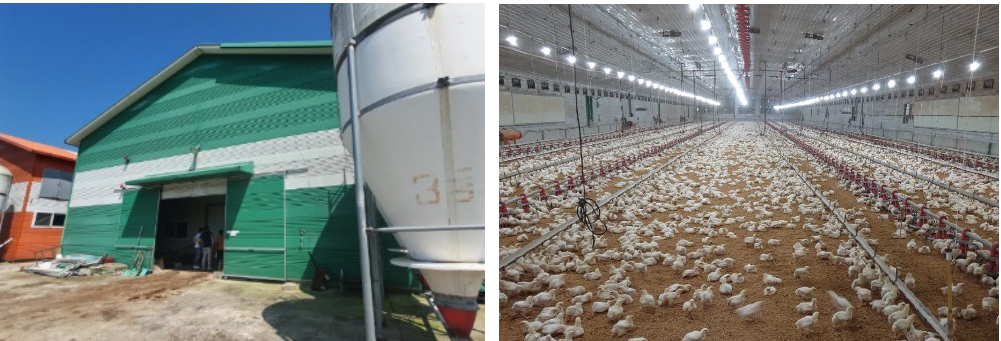
Figure 2. Outside and inside the field test facility for experiment (Latitude: 35.277, Longitude: 126.511,